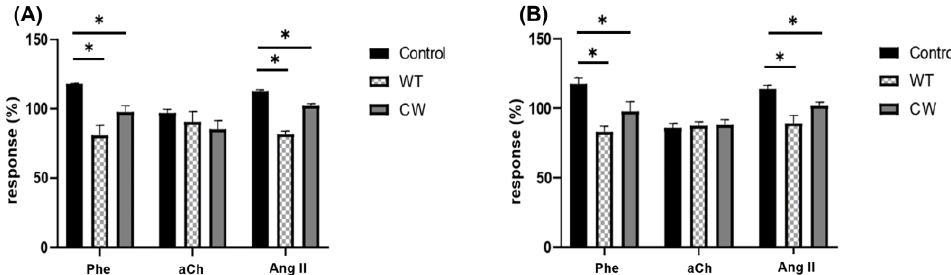
Figure 4. Modification of CPP and LVP in response to agonists when C. albicans ’ cell wall interacts with coronary endothelium. ( A ) Heart response, expressed as percentage of response of CPP and ( B ) LVP, when Phe, aCh and Ang II are administered in the absence (control) and in the presence of C. albicans WT yeasts (WT) or purified C. albicans WT cell walls (CW). Bars (mean ± SD) show the result of at least three independent experiments (* p < 0.05).